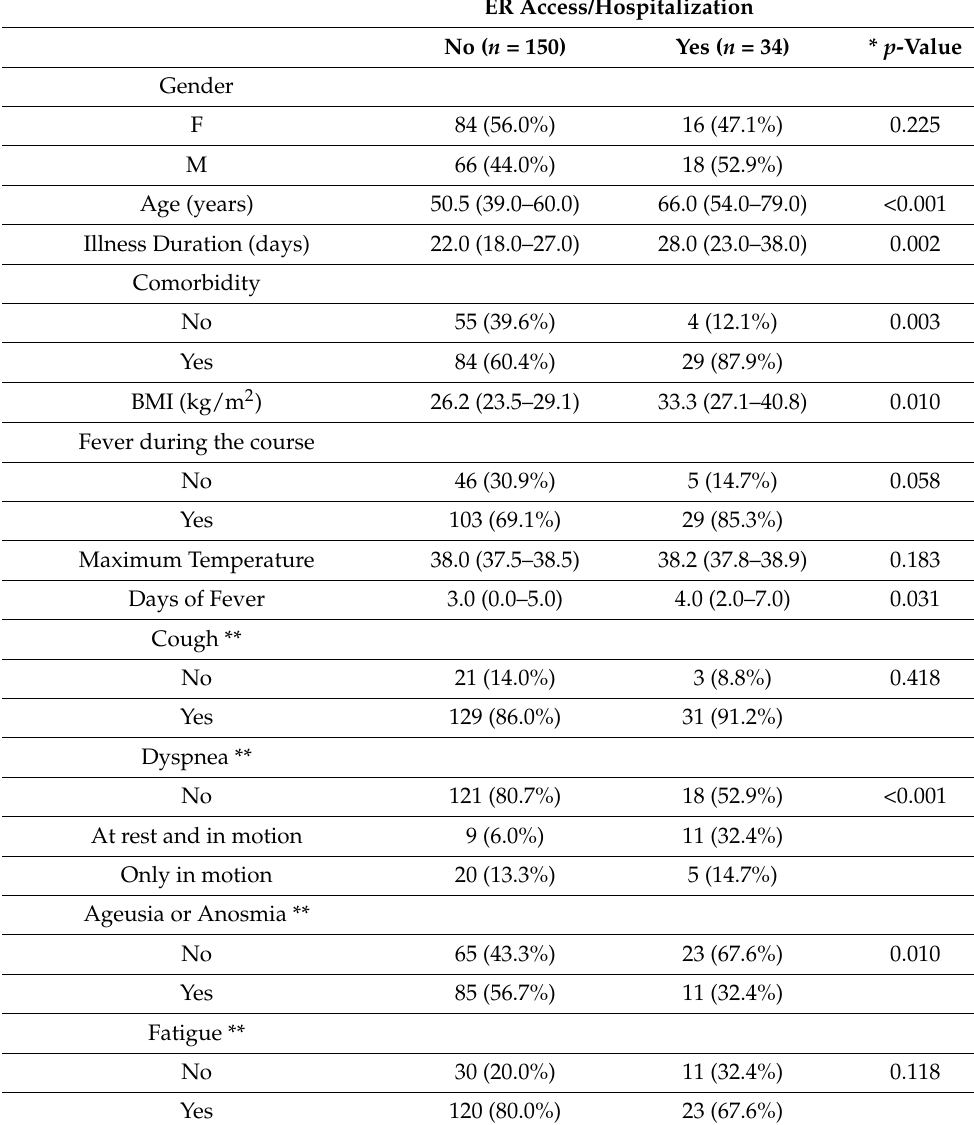
Table 3. The patients’ socio-demographic and clinical characteristics for ER access/hospitalization ( n =